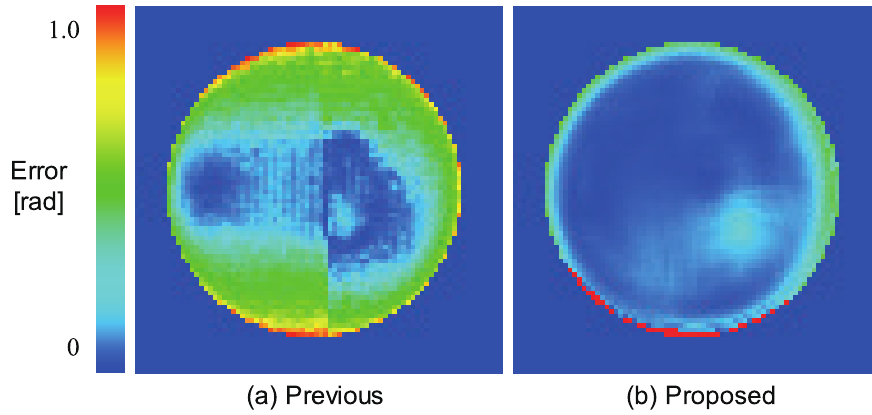
Figure 14. The error map of the sphere where the error is represented as angular difference between estimated value and ground truth (red: large, blue: small): ( a ) Naive color photometric stereo and ( b ) our method.